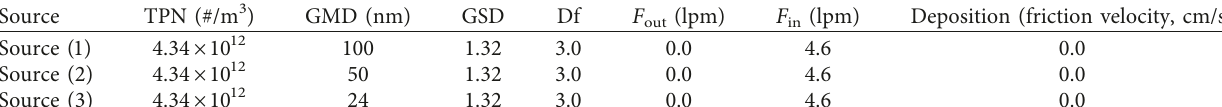
Table 2: Parameters used in (3) for sources.